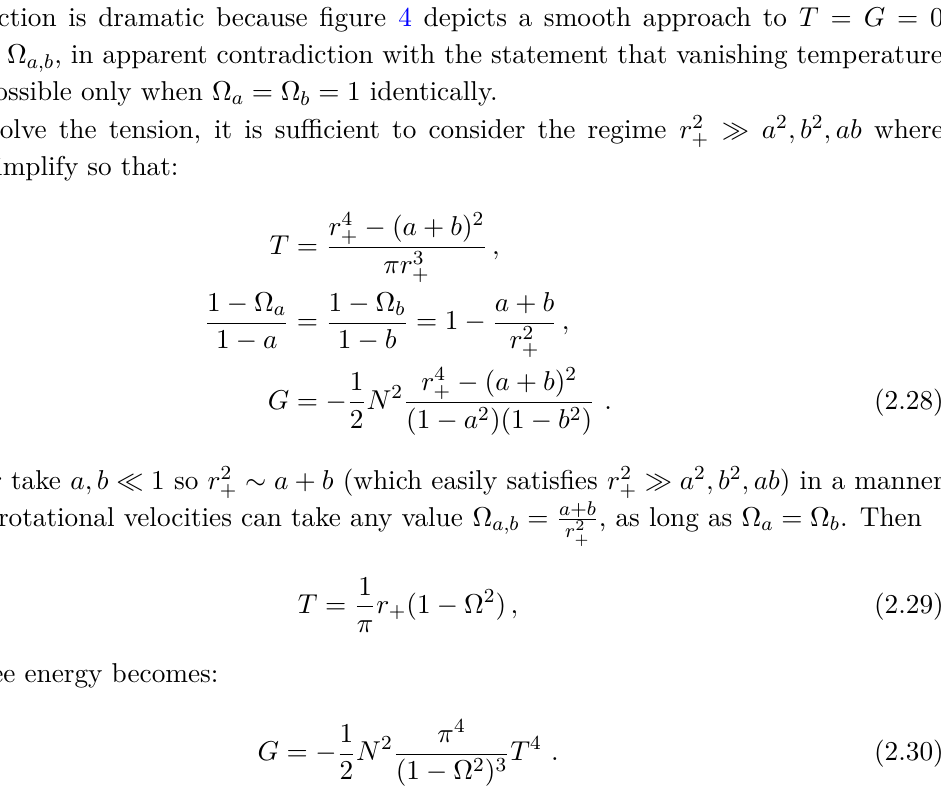
system all the way to T = 0 , while keeping the physical angular velocities Ω ure 4 shows the resulting free energy G as function of temperature T , for various values of Ω = Ω a b